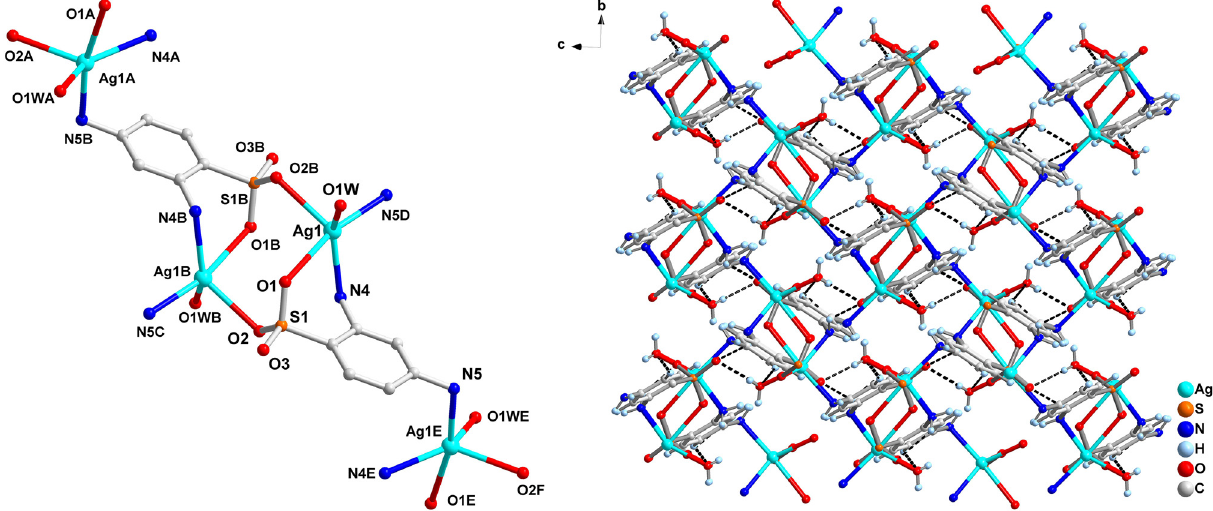
Table  : Data collection and